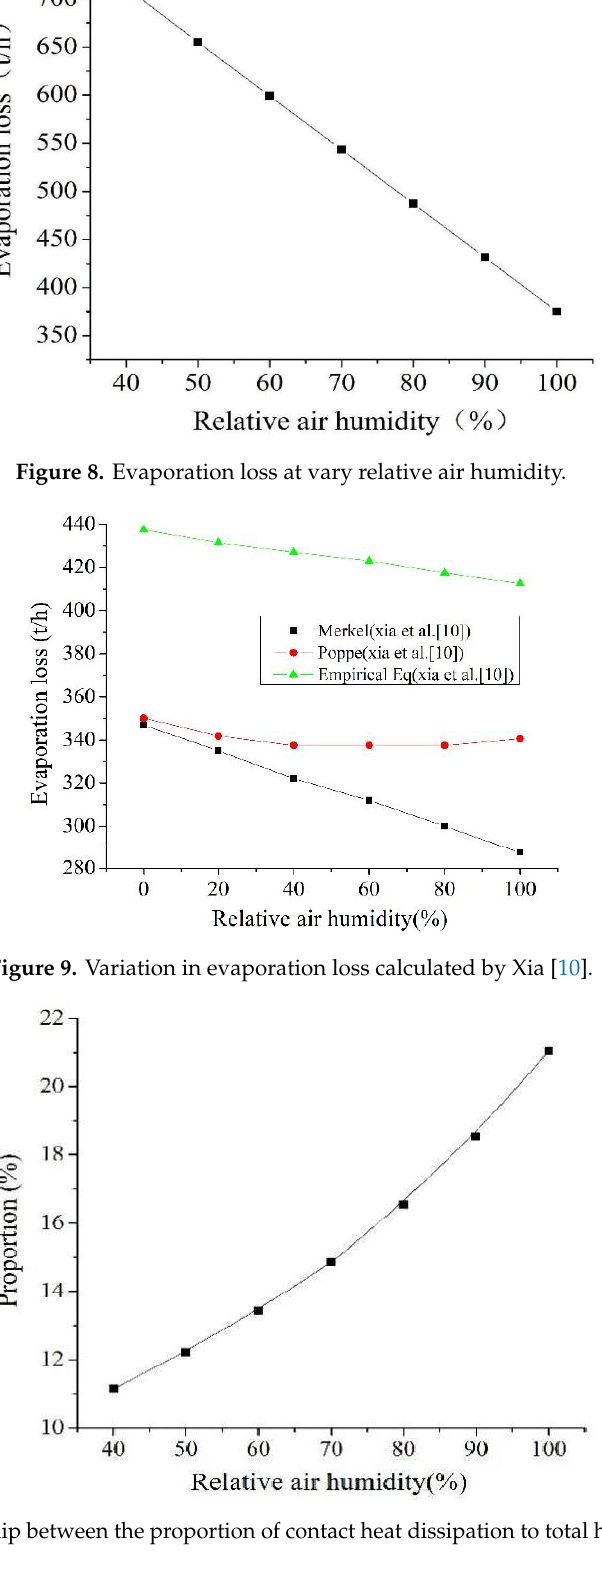
Figure 10. Relationship between the proportion of contact heat dissipation to total heat dissipation and relative air humidity.